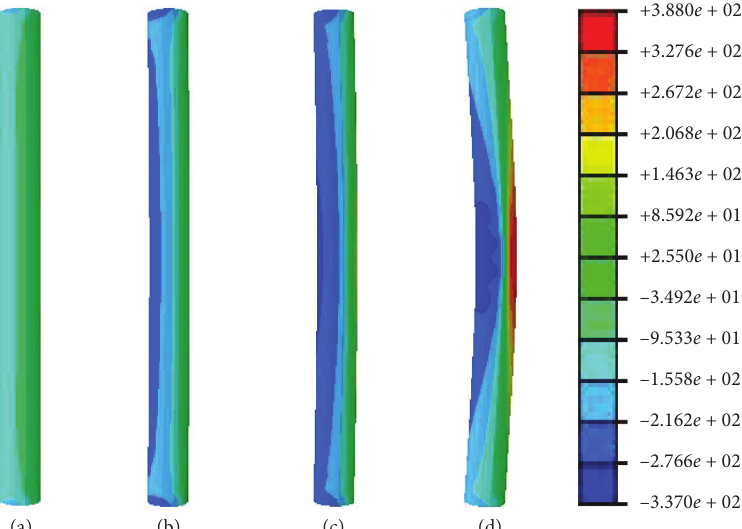
Figure 16: The longitudinal stress contour maps of the stainless steel tube. (a) Point A. (b) Point B. (c) Point C. (d) Point D.